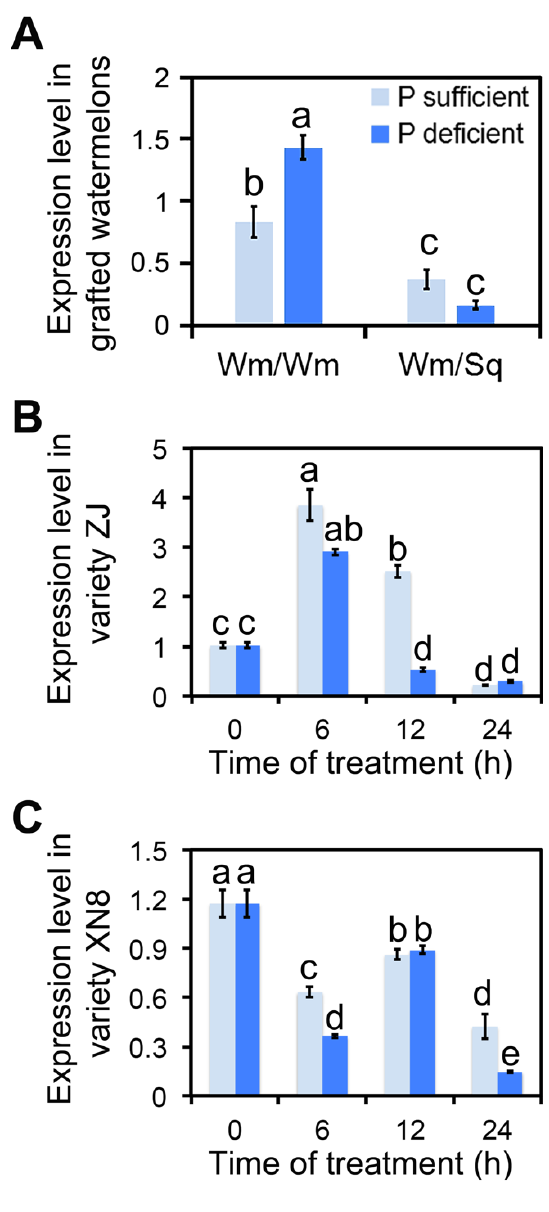
Figure 3. ClCIPK5 was regulated by grafting and phosphate deficient stress. ( A ) Expression of ClCIPK5 in the leaves of auto- and squash-grafted watermelon. “Wm/Wm” and “Wm/Sq” represent auto-, and squash-grafted watermelon (ZJ), respectively. ( B ) Expression of ClCIPK5 in the roots of inefficient P utilization genotype “ZJ” under different P concentrations. ( C ) Expression of ClCIPK5 in the roots of efficient P utilization genotype “XN8” under different P concentrations. Different lower-case letters indicate significant in expression level ( p < 0.05, one-way ANOVA and then Tukey’s test for multiple comparisons). Values are means ± SD ( n = 3).